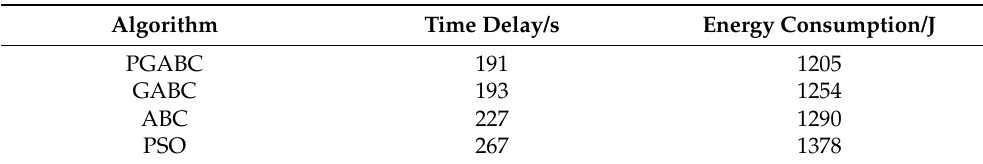
Table 6. The optimization results of each algorithm for the delay and energy consumption when the quantity of fog clusters was